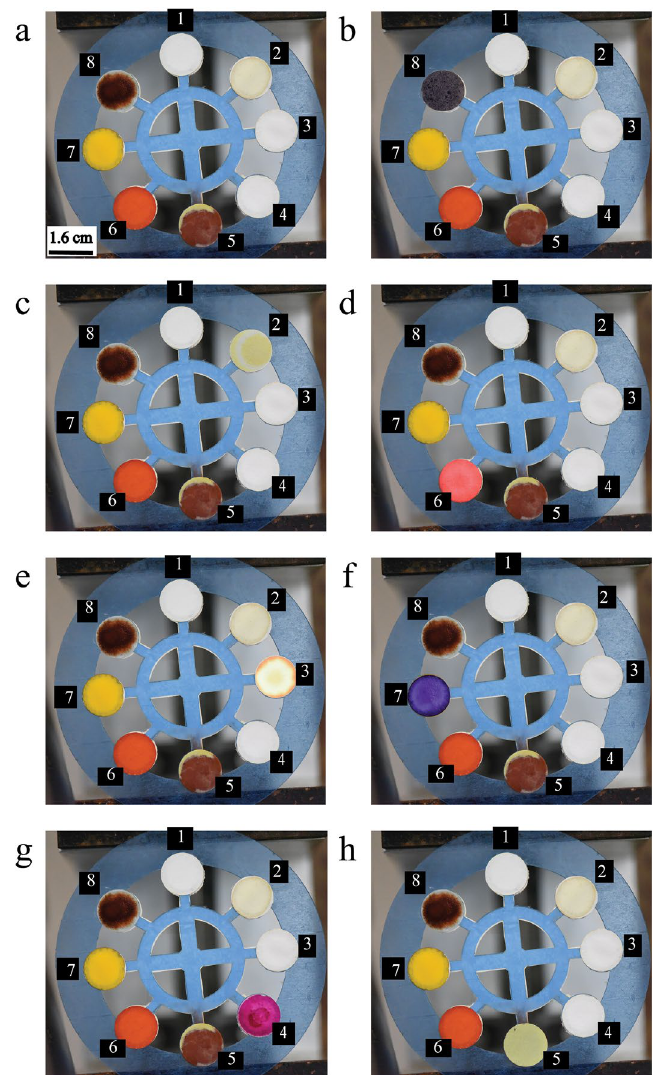
Figure 5. Experimental results of specificity test. ( a ) Only the reagents are showing in the different detection zones where the number represents the detection zones for urea (2), H 2 O 2 (3), soap (4), salt (5), NaHCO 3 (6), detergent (7), starch (8) and control (1). Specificity of the reagents have been shown for ( b ) starch, ( c ) urea, ( d ) NaHCO 3 , ( e ) H 2 O 2 , ( f ) detergent, ( g ) soap, and ( h )